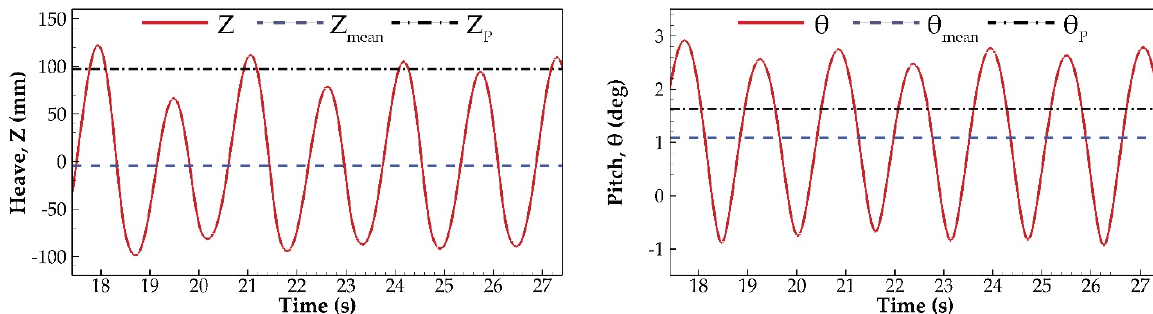
Figure 11. Time histories of heave and pitch motions, λ /L = 1.50.